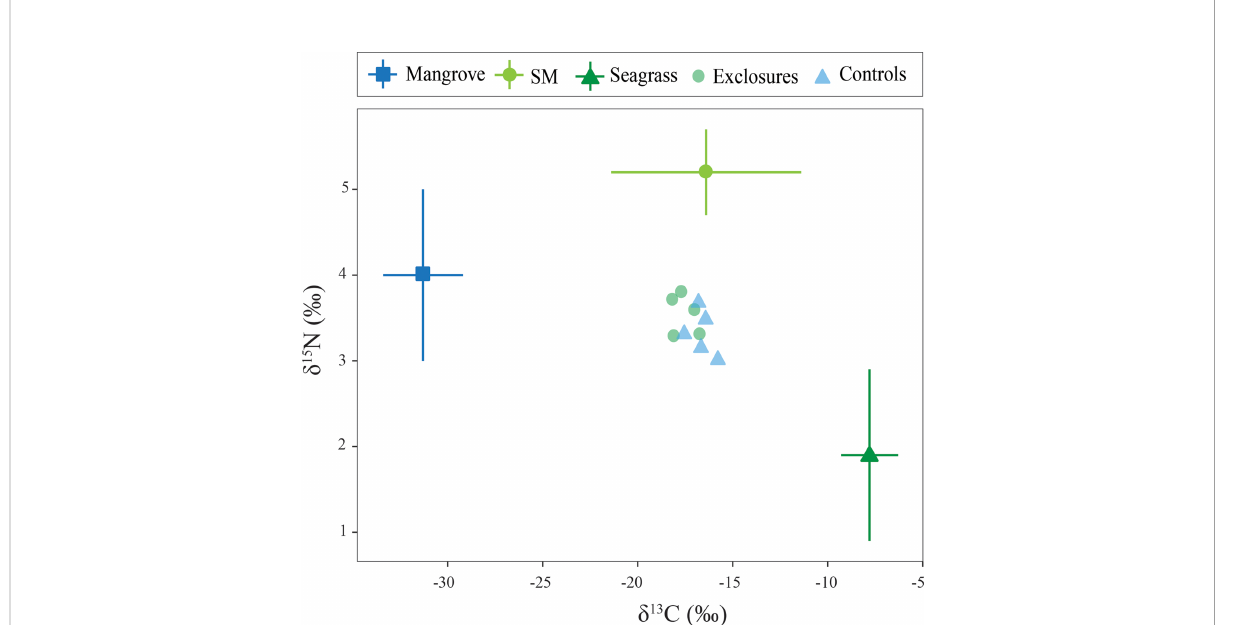
FIGURE 5 Sediment carbon and nitrogen isotopic values within exclosures and control plots following 13 months of megaherbivore exclusion at Cahuita National Park, Costa Rica. Potential sources used in the mixing models are also included in the graph for comparison.